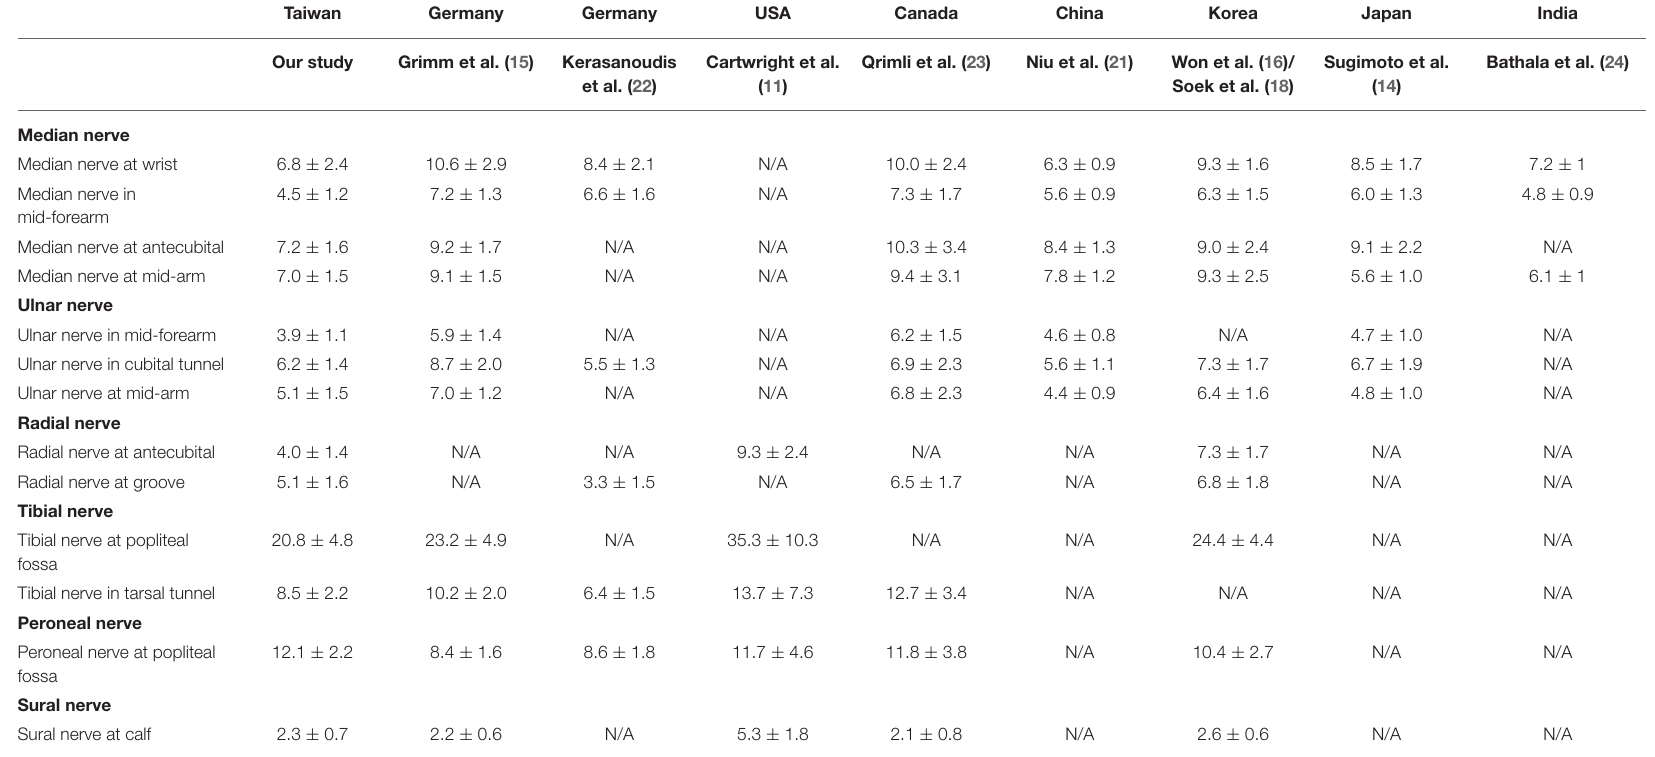
TABLE 5 | Comparison of published CSA values from cohorts of different